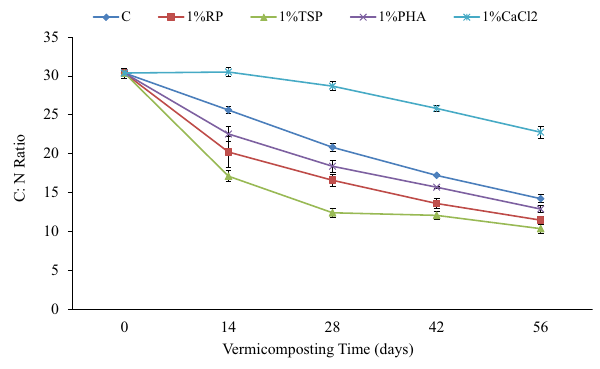
Fig. 3 Effect of P and Ca source on the C:N ratio Fig. 4 Effects of P and Ca sources on inorganic nitrogen